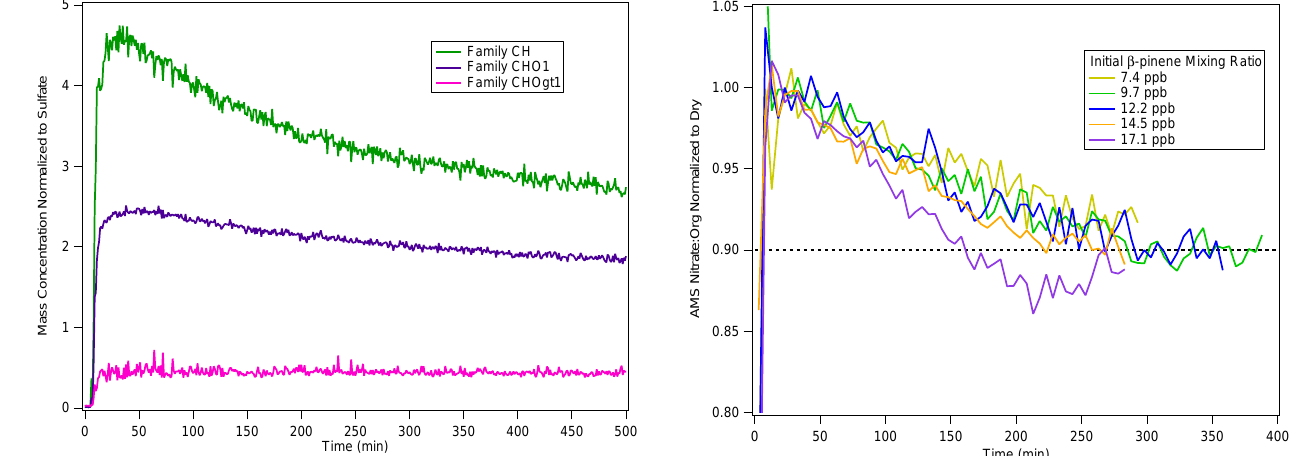
Figure 7. The AMS nitrate : org ratio of humid (RH = 50%) exper- iments normalized to the corresponding dry experiments with same initial β -pinene mixing ratio, 5min averaged, for “RO 2 + NO 3 dom- inant” experiments. This ratio is referred to as (nitrate : org) norm in the main text. For comparison purposes, all data are normalized to the highest (nitrate : org) norm